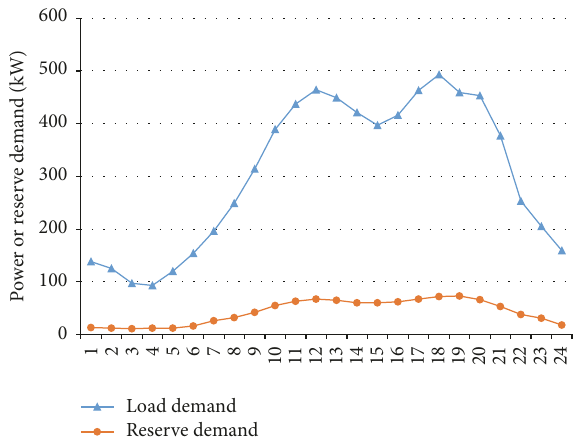
Figure 2: Distribution of load demand in the MG under three cases.